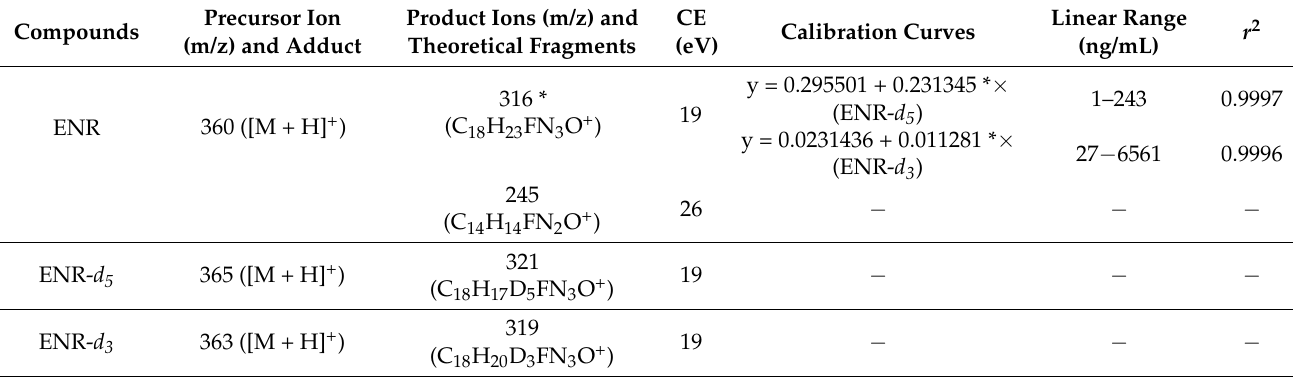
Table 1. MS/MS parameters and standard curves with two isotope